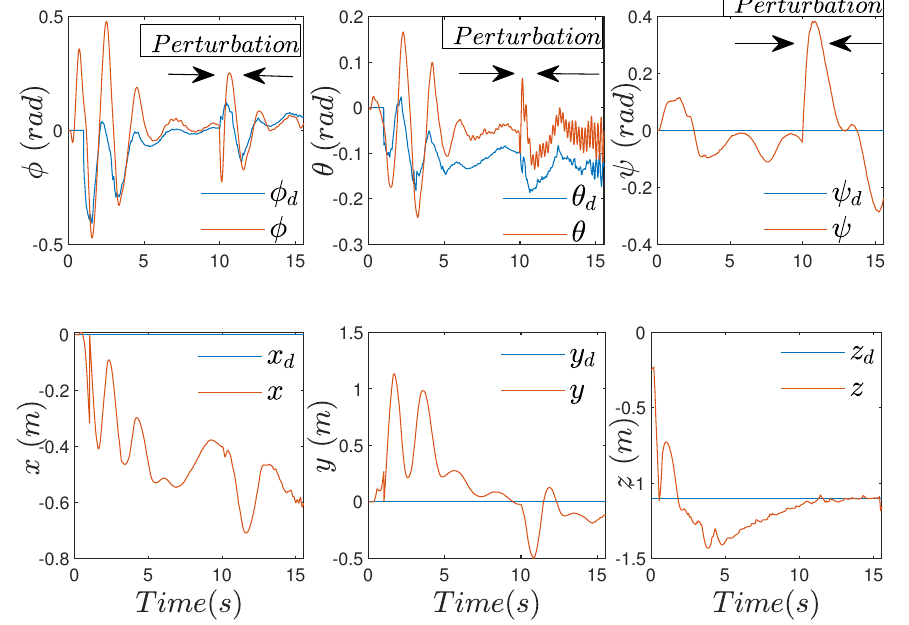
Figure 8. Hovering. Pose of the quadrotor MAV subject to external perturbations.